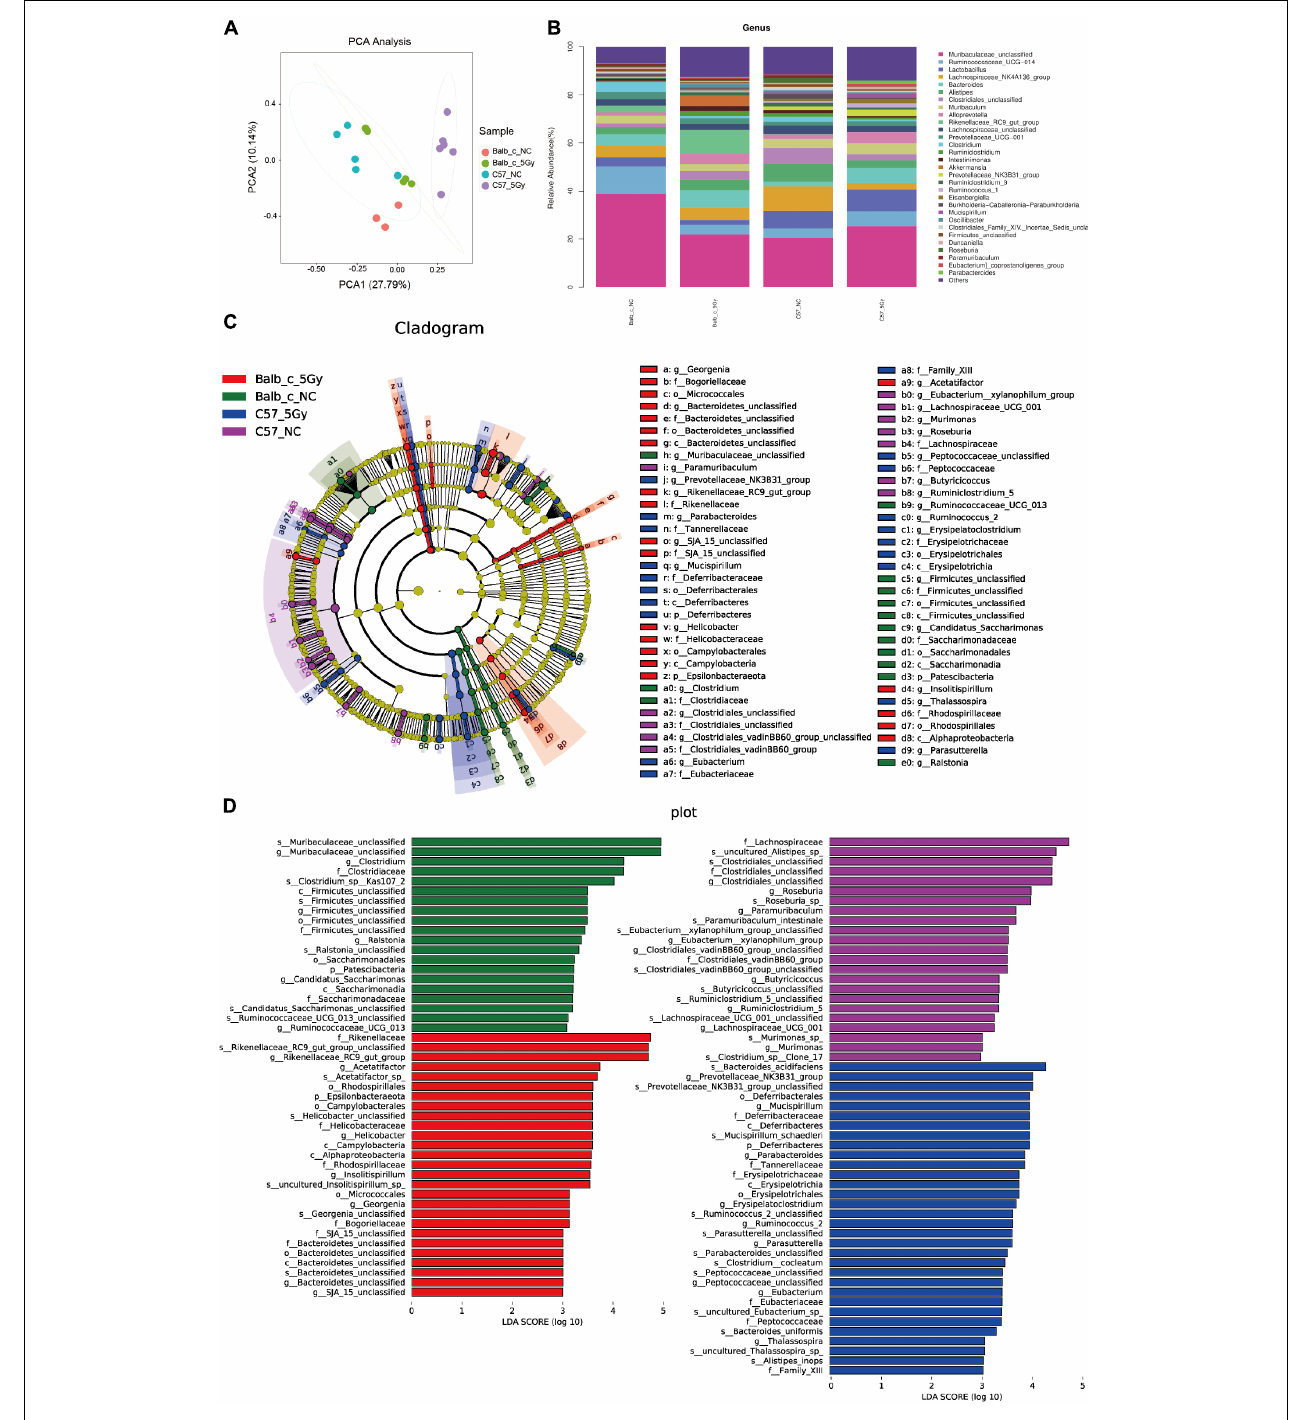
FIGURE 3 | Cladogram and linear discriminant analysis (LDA) by LEfSe analysis showing the biomarker taxa associated with Balb/c and C57BL/6J group. (A) PCA score plots based on Bray–Curtis distance at genus level. (B) Taxonomic summary of the gut microbiota of Balb/c and C57BL/6J at genus level. (C) A cladogram using the linear discriminant analysis (LDA) effect size (LEfSe) analysis shows the phylogenetic distribution of the different groups of gut microbiota. Each successive circle represents a phylogenetic level. Dot size is proportional to the abundance of the taxon. [phylum (p), class (c), order (o), family (f), genera (g), species (s)]. (D) Histogram of the LDA scores reveals the most differentially abundant taxa among different treatments. (LDA > 3, P < 0.05; Balb/c-NC: n = 3; Balb/c-5Gy: n = 6; C57BL/6J-NC: n = 6; C57BL/6J-5Gy: n = 6).